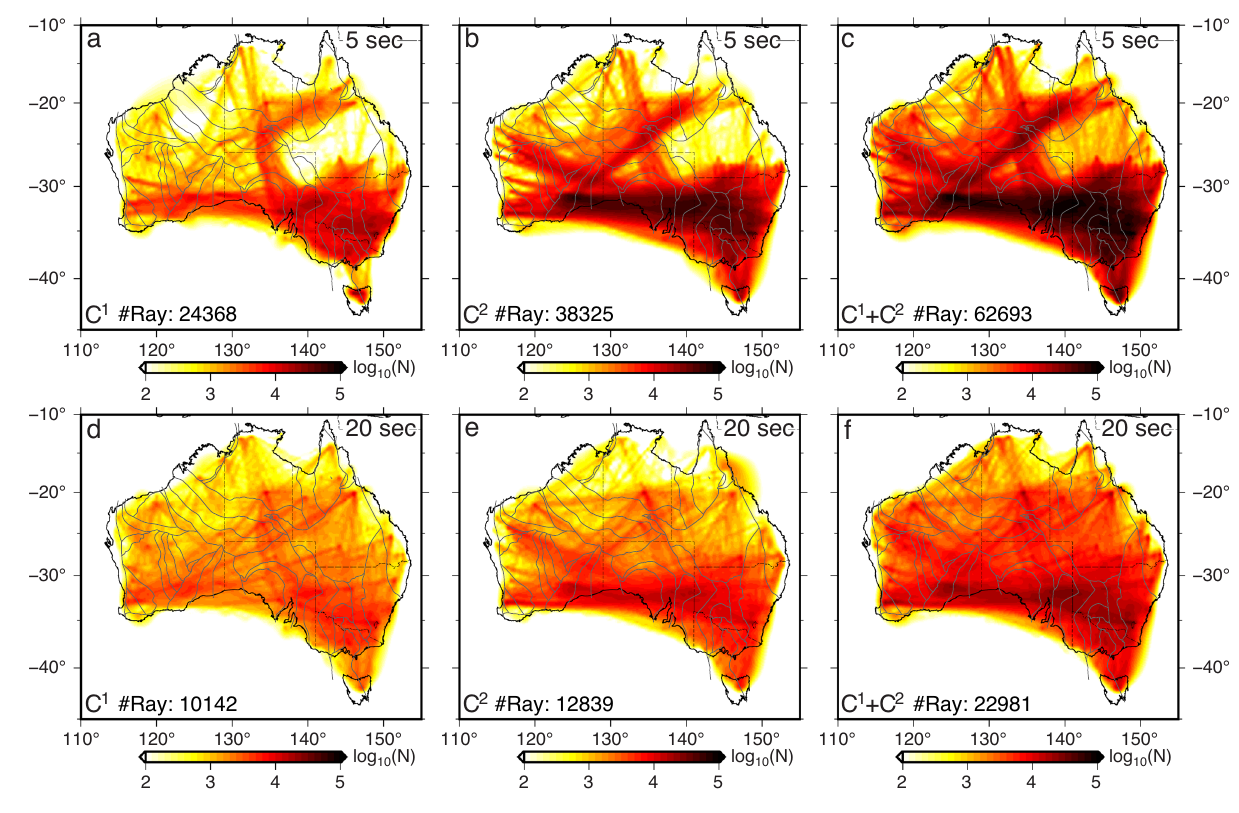
Fig. 2 | Comparison of the ray-path density retrieved using different methods. Ray-pathdensityattwoperiodsfrom( a , d ) C 1 ,( b , e ) C 2 and( c , f )combined C 1 and C 2